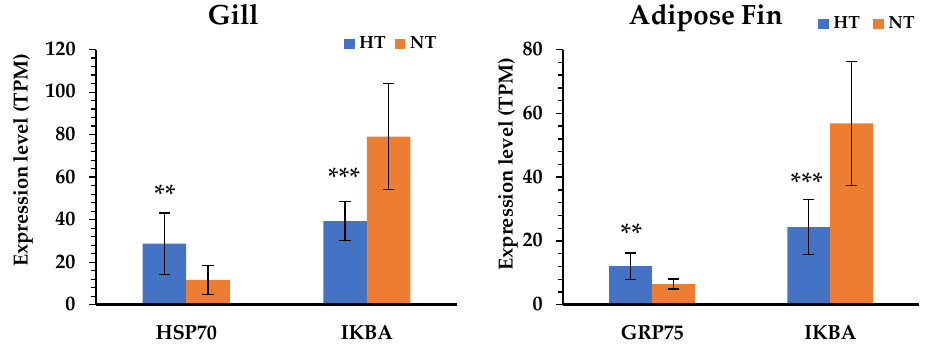
Figure 4. Comparison of the gene expression level between the HT and NT groups determined by normalized reads (TPM). The blue bars represent the gene expression of the HT group; the orange bars represent the gene expression of the NT group. Differences in statistically significant expression are marked ( ( * ) p < 0.05; ( ** ) p < 0.01; ( *** ) p < 0.001).